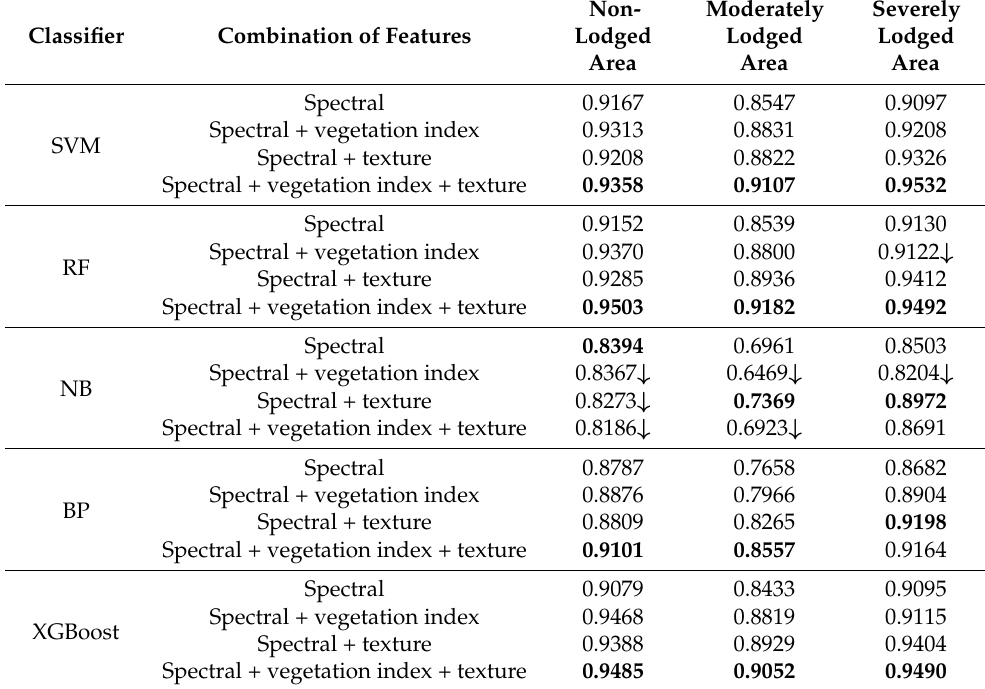
Table 8. F1 scores using different classifiers and a combination of image